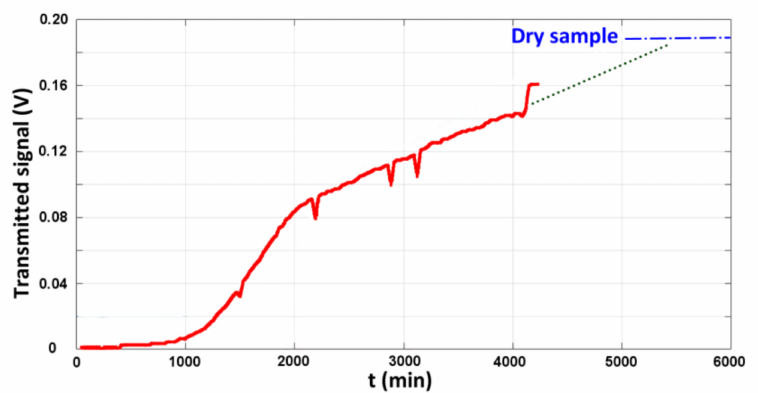
Figure 27. Transmission of the mosaic sample during the drying